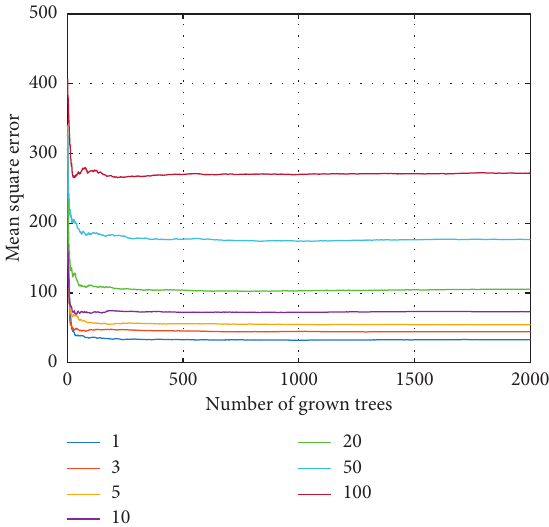
Figure 5: Values of MSE in function of grown tree number and leaf size